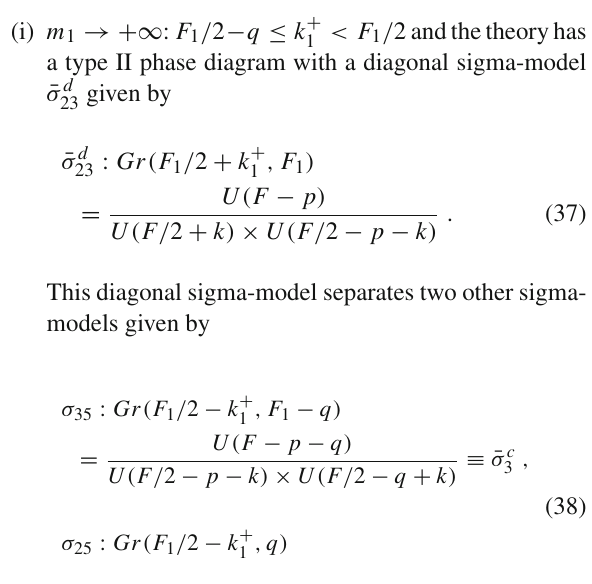
one-dimensional sigma-model σ . In the limiting case q = 0, the Chern–Simons level range becomes F / 2 − p ≤ k < F / 2 and the phase diagram is reduced to Fig.